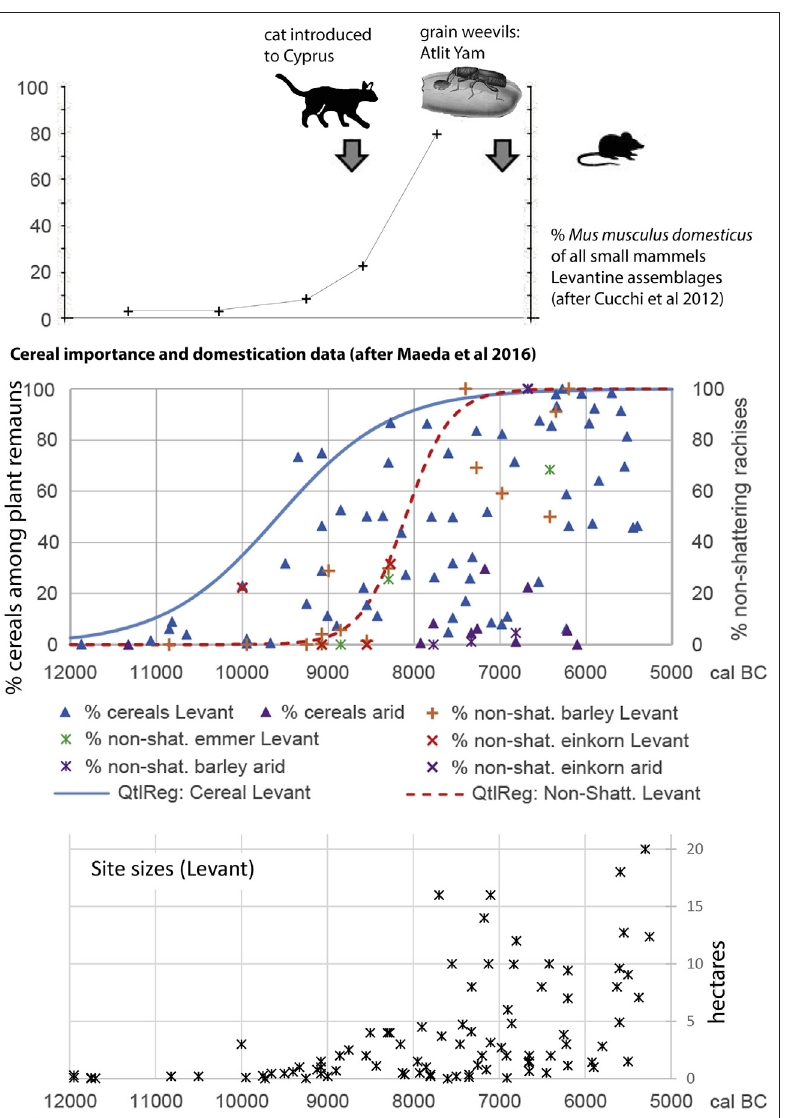
Figure 3: Relationship of animal parasitic domesticoids (% of Mus musculus ) and earliest grain weevils (top from Cucchi et al. 2012) with shattering data (% of non-shattering domesticated rachis types), and % of cereal remains to all other charred remains (middle from Maeda et al. 2016) and site size (in hectares) for the Near East (bottom from authors’ own data). related pest of some tropical fruits and 2010). From an ancestral preference for nuts seeds, while the rest of the genus consists of and tree fruits, three of these species have 10 species, largely confined to Eurasia and moved into the human-constructed agricul- infecting mainly the acorns of oak trees, or a tural niche. limited range of trees, for example tropical The primary dispersal mechanism for these Asian Dipterocarps and tree legumes (Plarre three grain store species is human